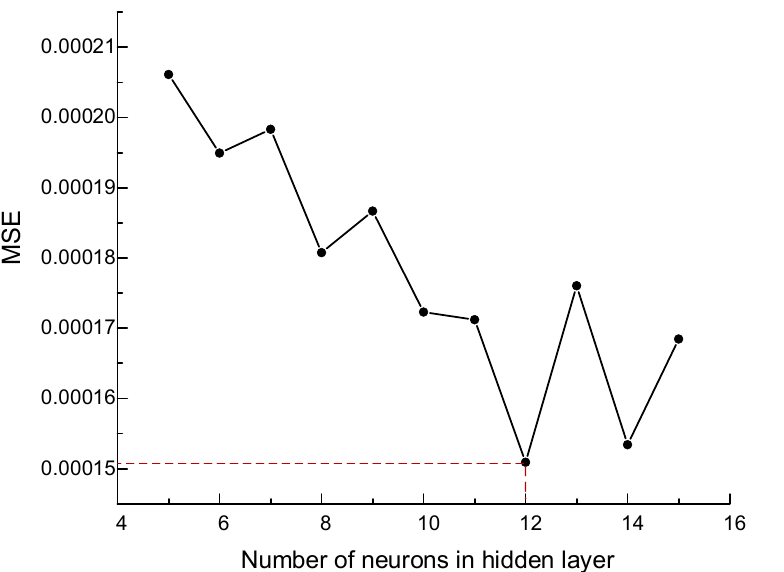
Figure 9. Network training error when the number of hidden layer neurons is between 5–15.